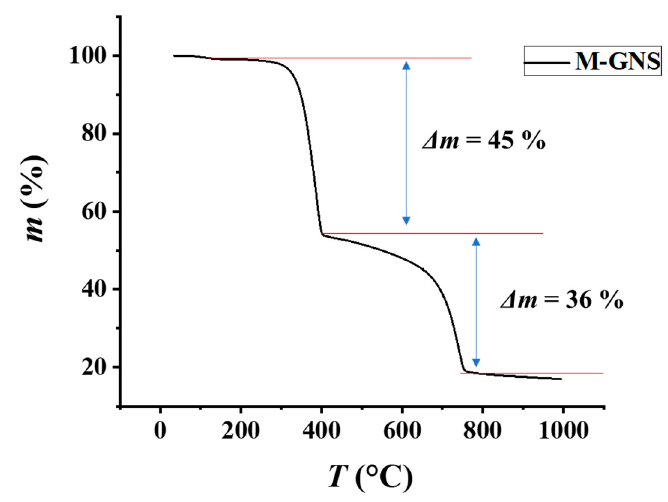
Figure 4. Thermogravimetric analysis (TGA) curve showing the mass loss profile of M-GNS.